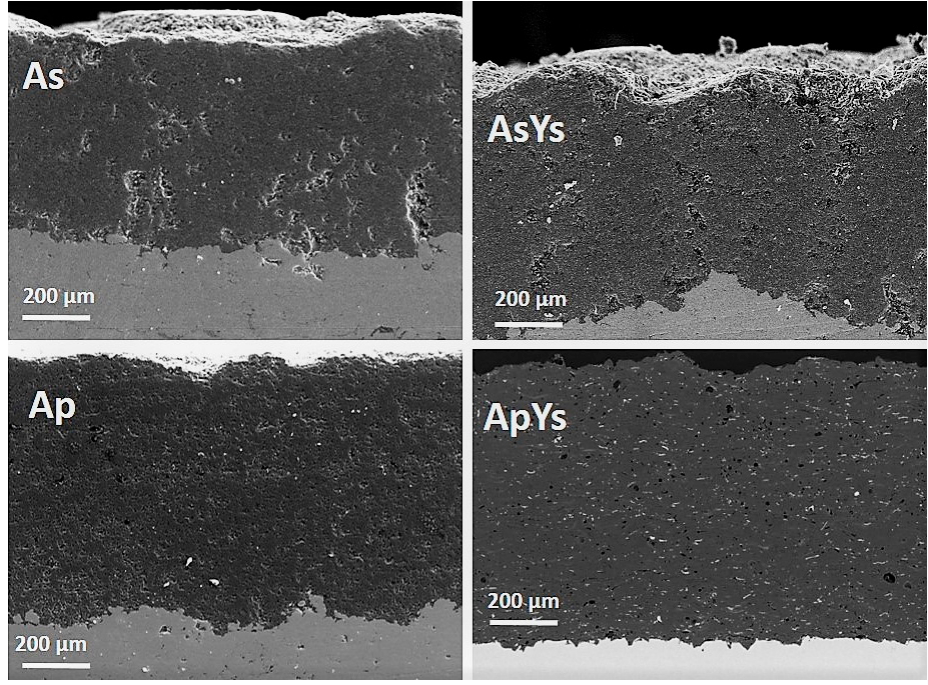
Figure 4. Cross-sectional SEM images of As, AsYs, Ap, and ApYs coatings taken at higher magnification.